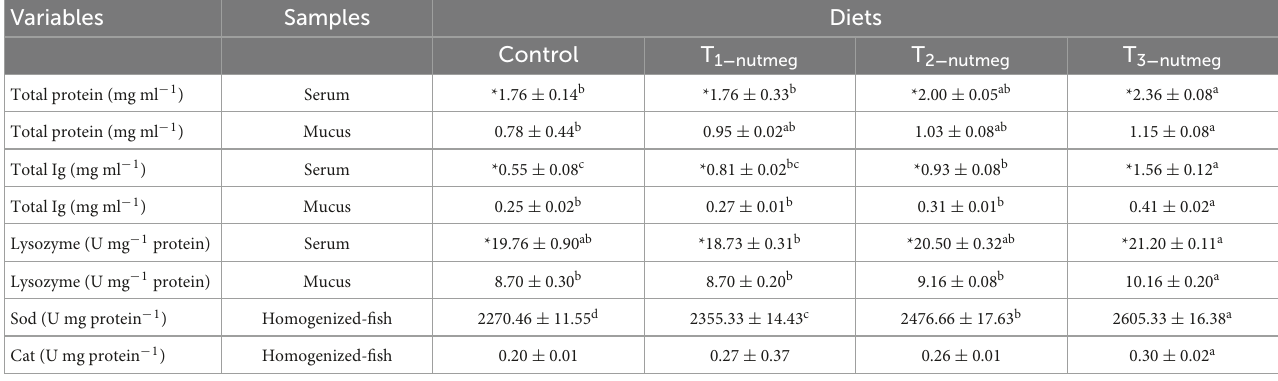
TABLE 5 Immune indices [total protein, total immunoglobulin (Ig), and lysozyme activity] and antioxidant activity [superoxide dismutase (Sod) and catalase (Cat)] of zebrafish fed the experimental diets.